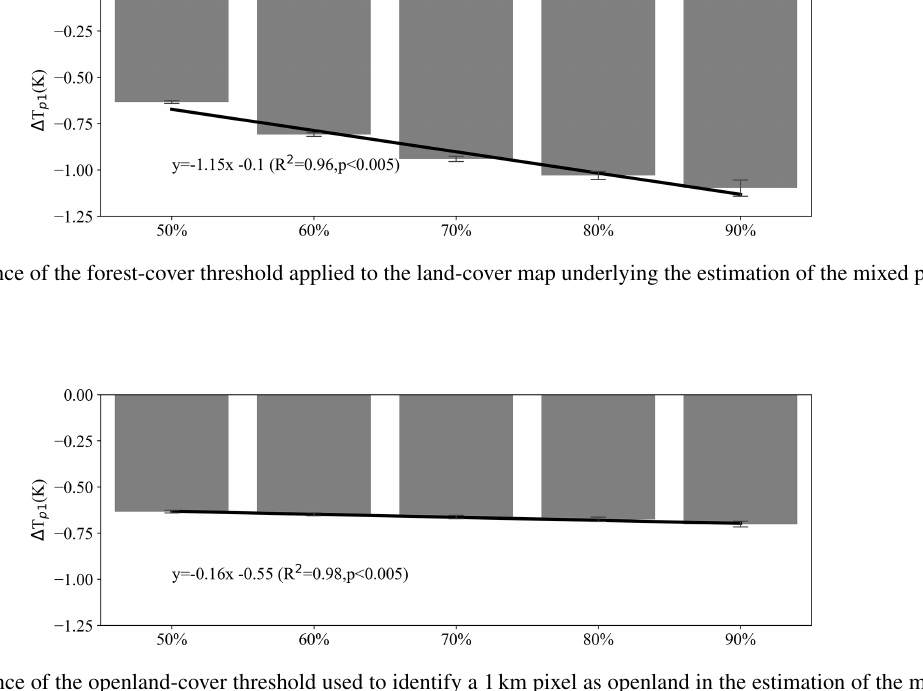
Figure A7. The influence of the openland-cover threshold used to identify a 1km pixel as openland in the estimation of the mixed potential effect ( (cid:49)T p ). 1